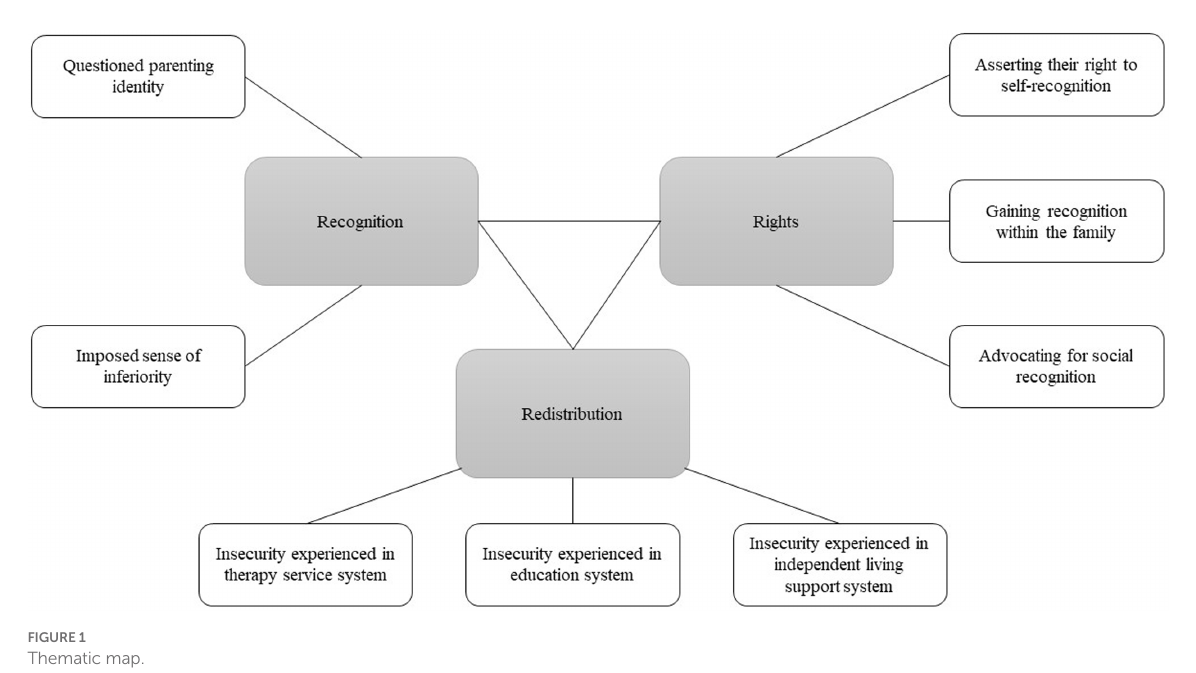
FIGURE 1 Thematic